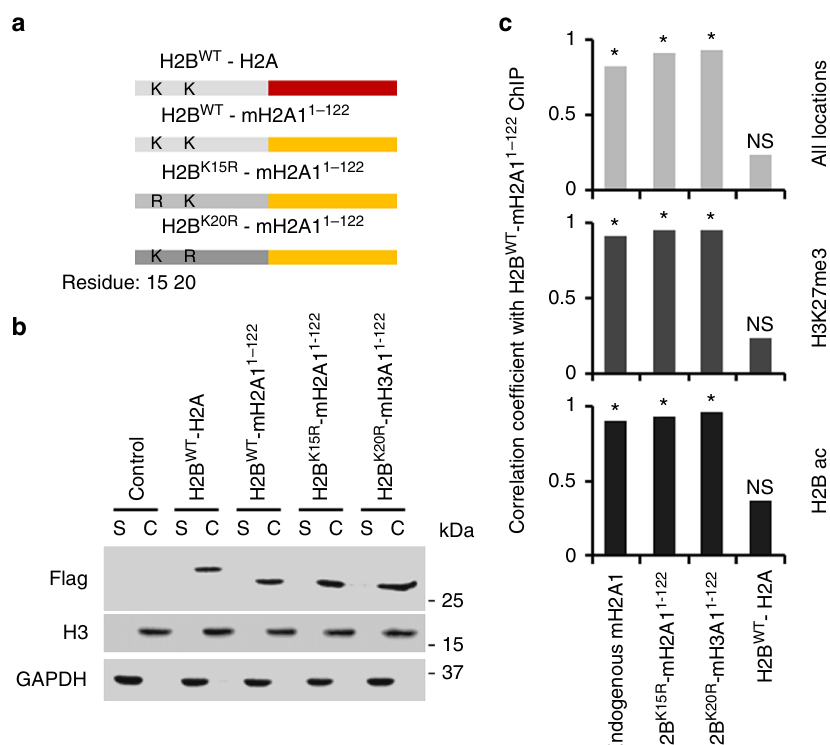
Fig. 6 H2BK20ac is a beacon targeting macroH2A1 deposition into H2B-acetylated chromatin. a Schematic for single chain constructs with H2B fused directly to H2A-type histone representing obligate H2B-H2A dimers. b Immunoblots of soluble (S) and chromatin fractions (C) from IMR90 cells described in a for indicated proteins. Cells were fractionated with detergent. Insoluble fraction was digested to mononucleosomes with MNase to assess competence for chromatin incorporation. c Pearson ’ s correlation coef fi cient calculated for Flag ChIP in H2B WT -mH2A1 1 – 122 -Flag expressing cells versus endogenous macroH2A1 ChIP in H2B WT -H2A-Flag expressing cells and versus Flag ChIP in single chain obligate histone dimer expressing cells described in a . ( n =